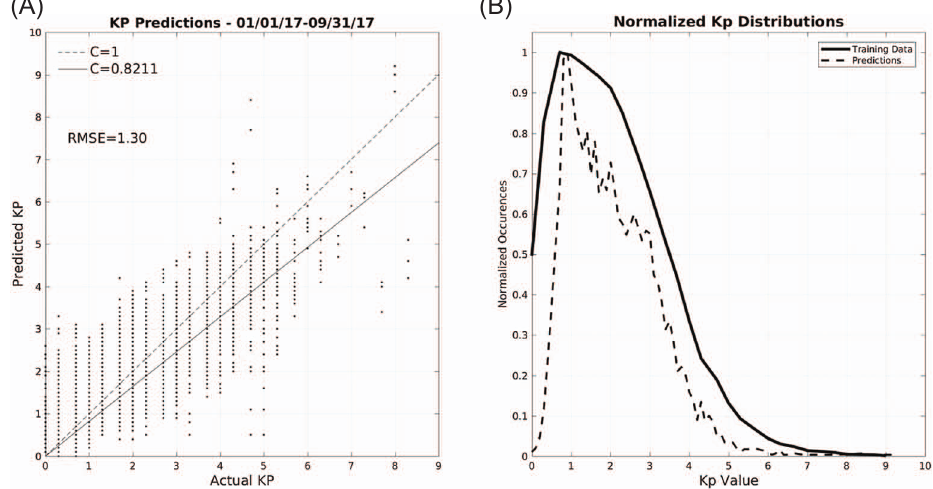
Fig. 6. (A) 6528 Kp predictions 01/01/2017 – 09/30/17 from the network trained on the original Wing model inputs with an additional parameter: B z , n , V , | B |, r B . (B) Frequency of Kp values for full data set 1986 – 2016 and 2017 predictions. Compared with Figure 5, the distribution of predictions more closely matches that of the training